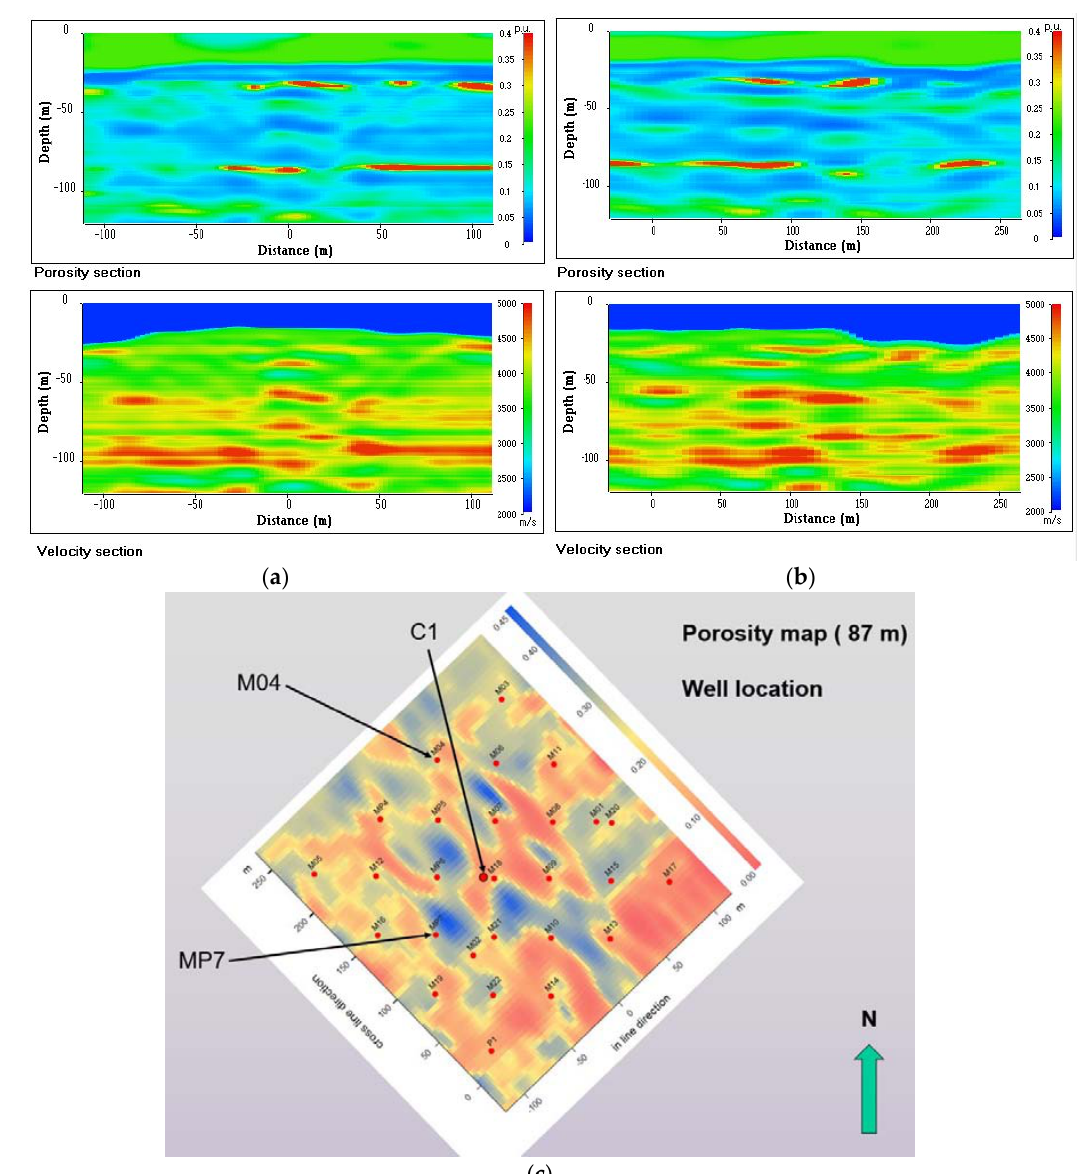
Figure 4. Velocity and porosity sections and porosity map ( a ) in line #21 section, ( b ) cross line #24 section, ( c ) porosity map at 87 m depth.